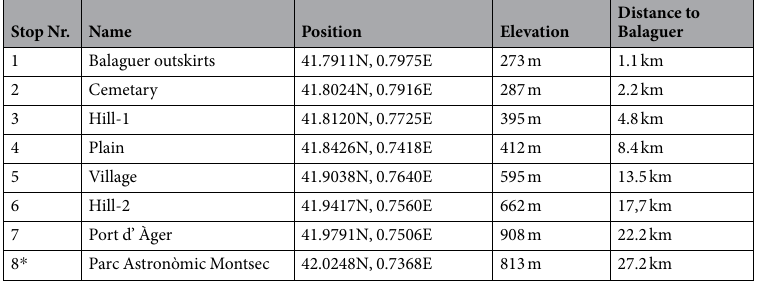
Table 3. List of the locations along the transect from Balaguer to Port d’ Àger. Stationary observations were performed during the entire period of the transect from the final location (Parc Astronòmic Montsec, PAM- COU).